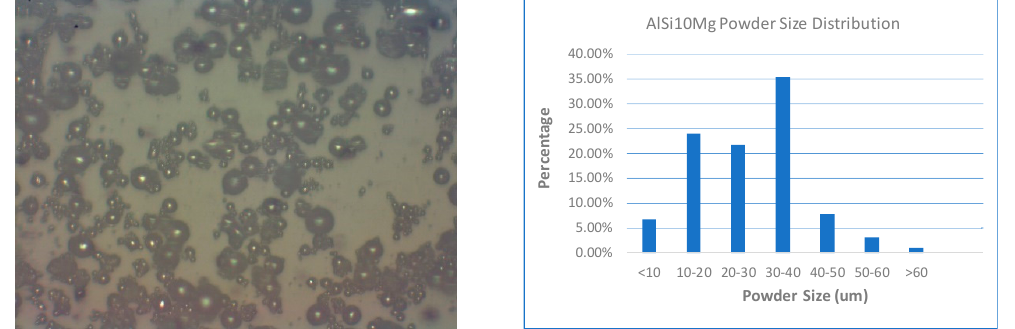
Figure 2. Characterization of Al alloy (AlSi10Mg) powder.